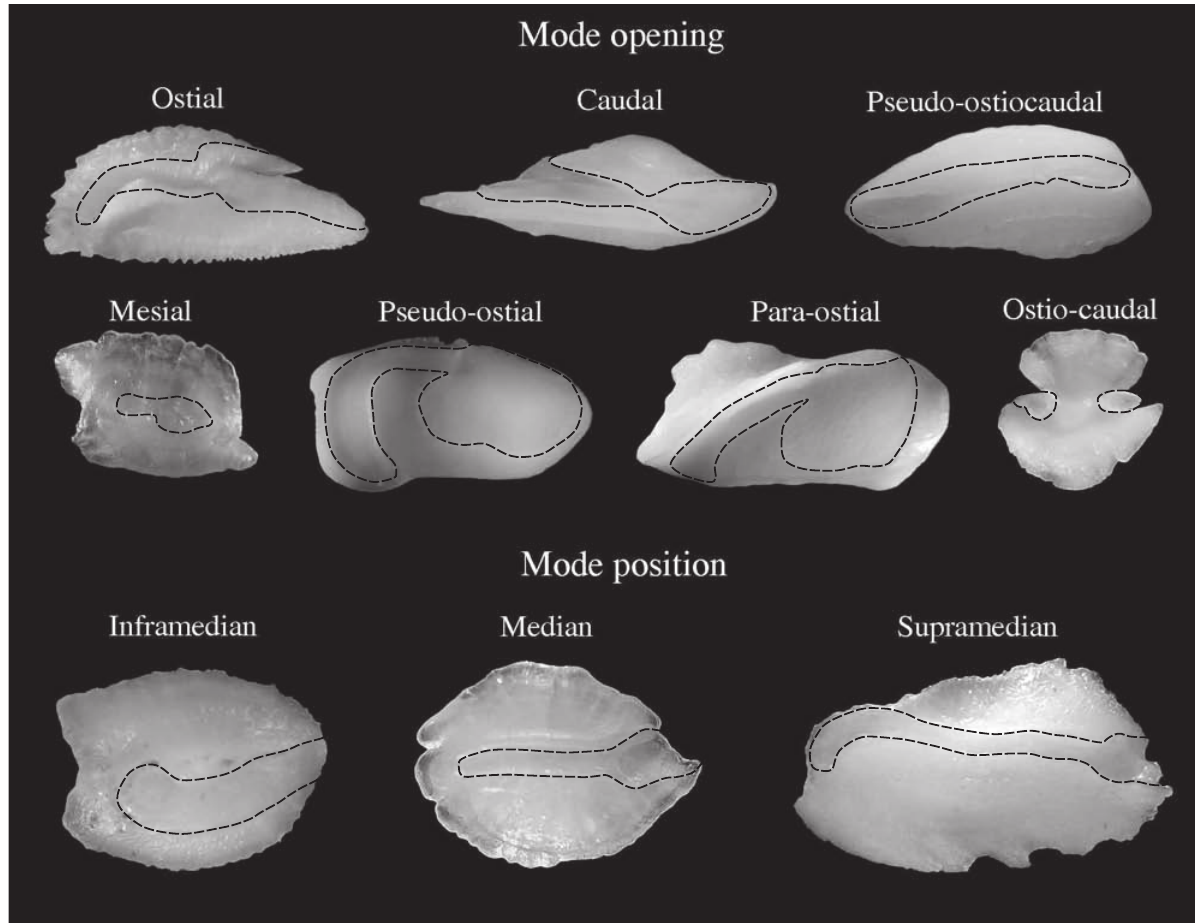
Fig. 5. – Terms used to describe different types of sulcus acusticus (sulcus limited by a discontinous